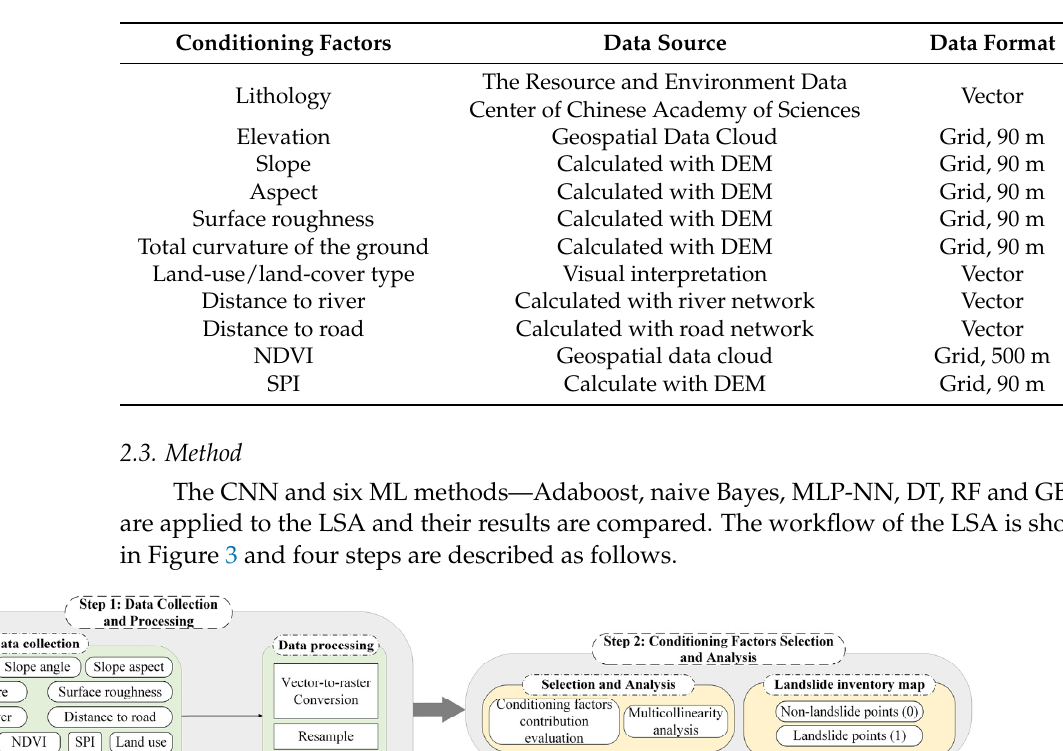
Table 1. Data source and format.